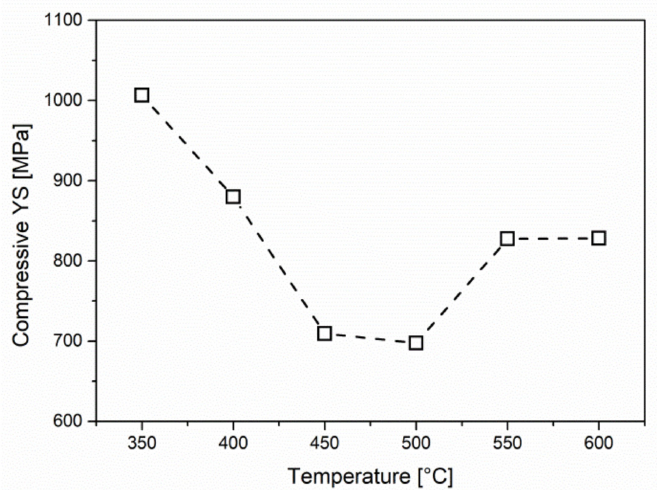
Figure 8. Compressive yield strength dependence on temperature of the isothermal heat treatment of the Ti-V steel examined (for 1200